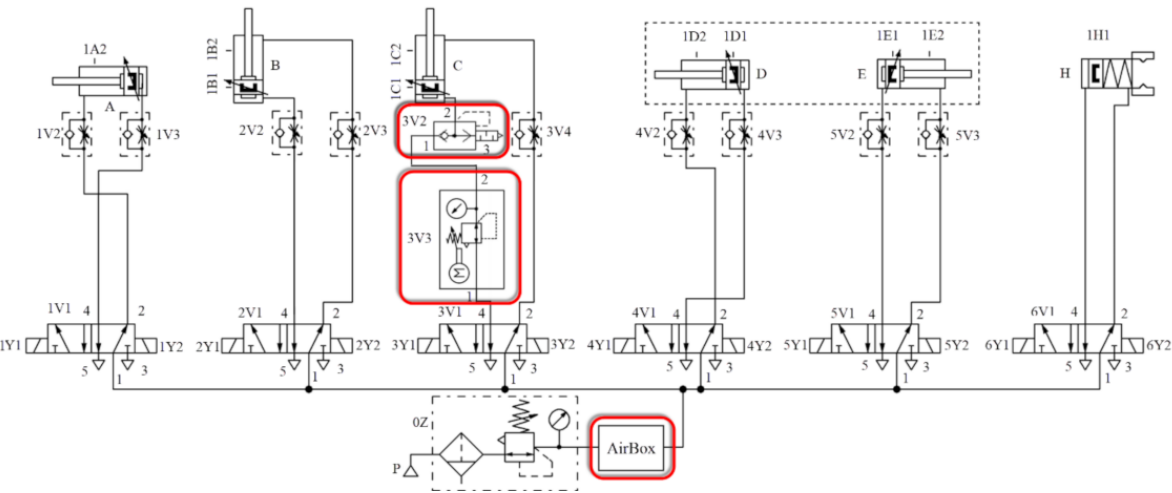
Figure 11. Pneumatic scheme of the experimental